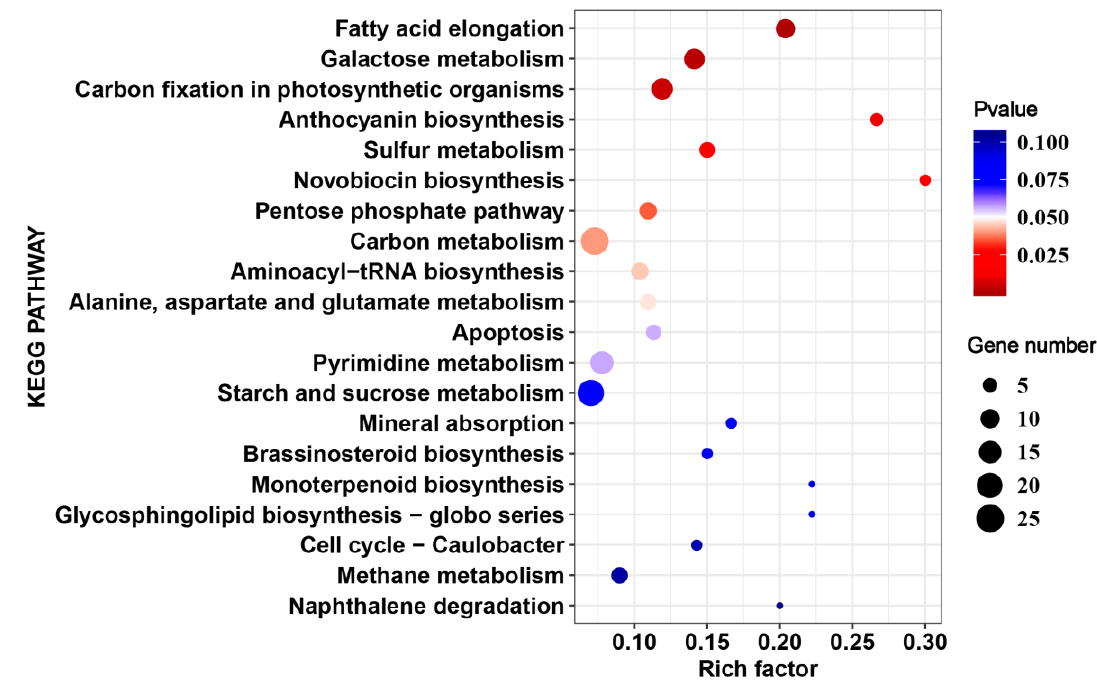
Figure 6. Top 20 enriched pathways for 05S180-specific heat responsive genes.